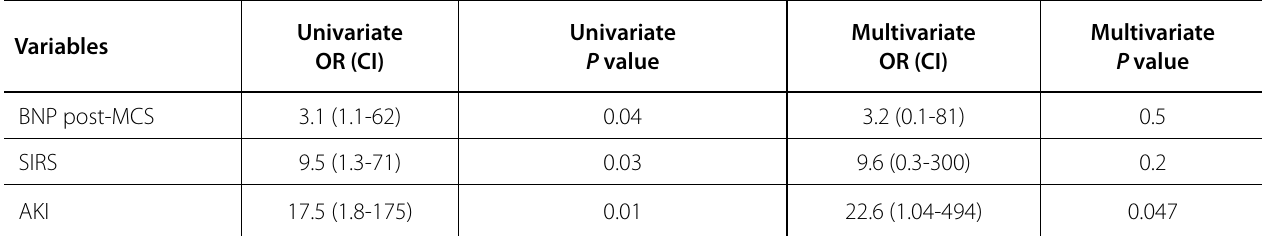
Table 4. Univariate and multivariate analysis of death.